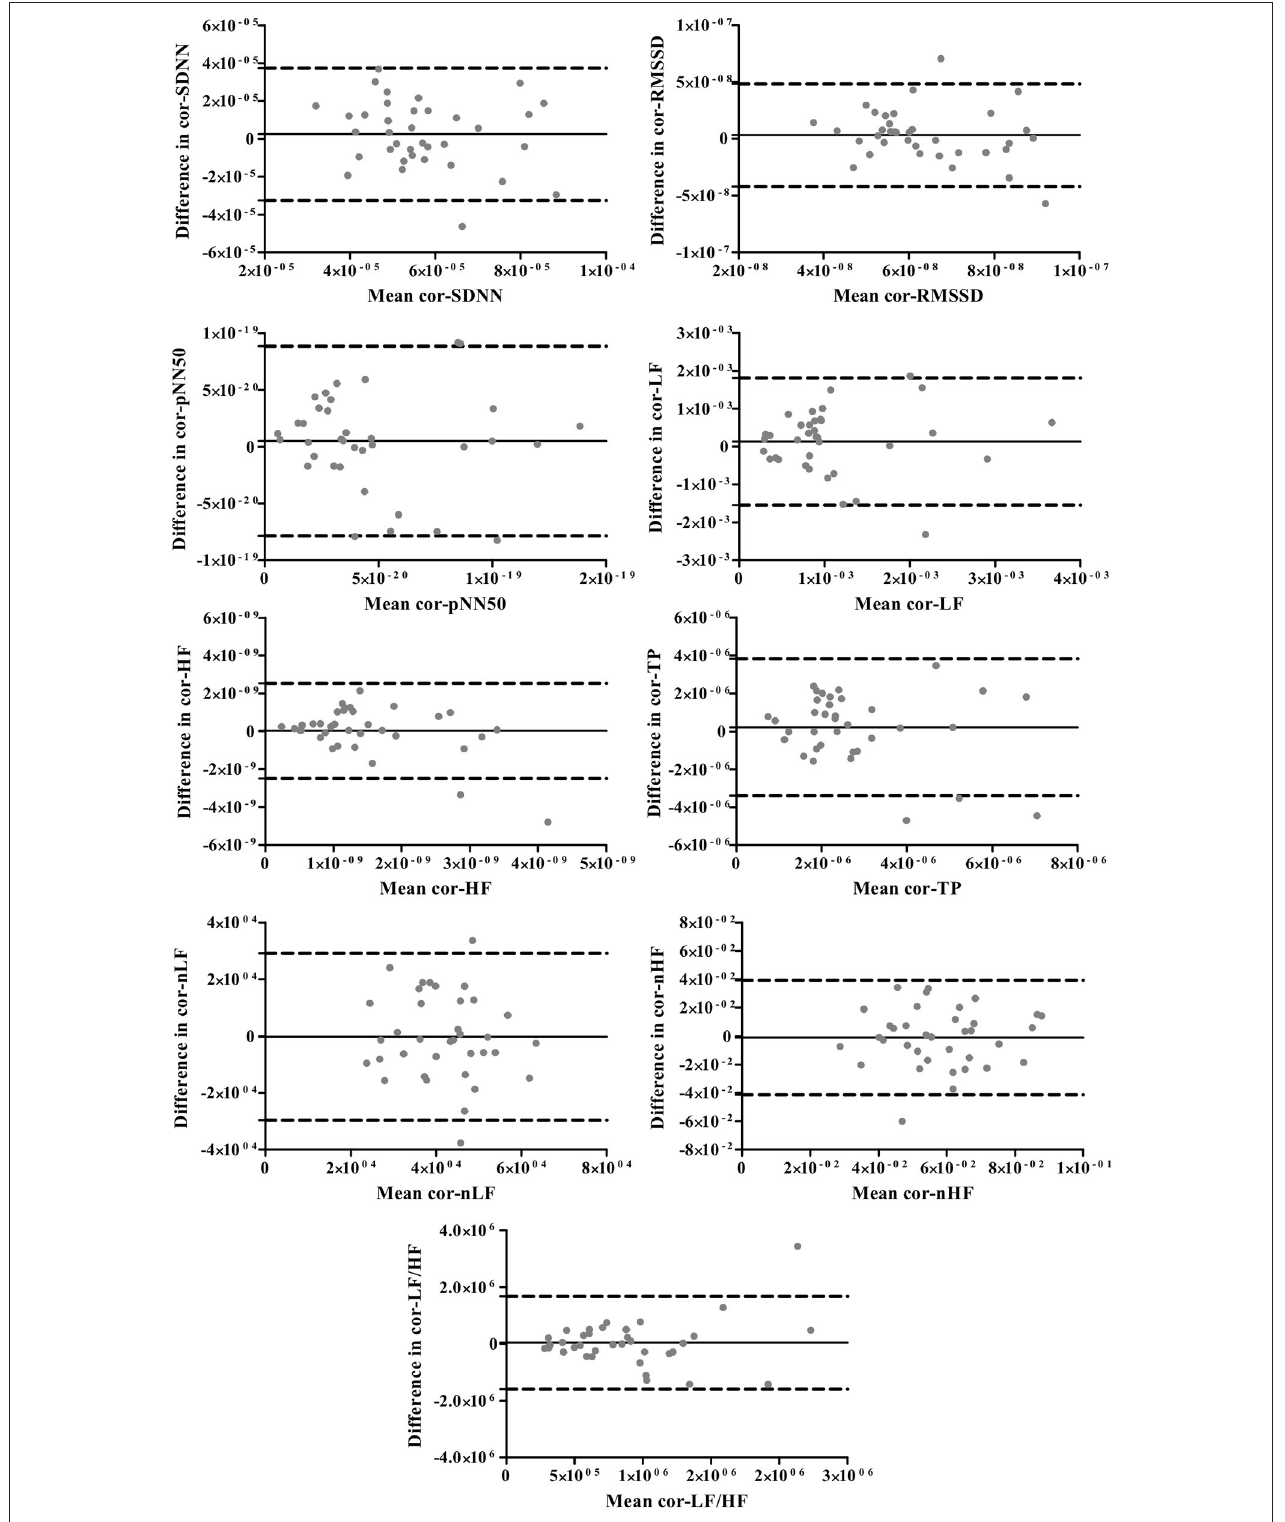
FIGURE 2 | The Bland-Altman plots for corrected HRV parameters. The solid lines indicate the bias, and dotted lines are the 95% limits of agreement ( ± 1.96 SD ).